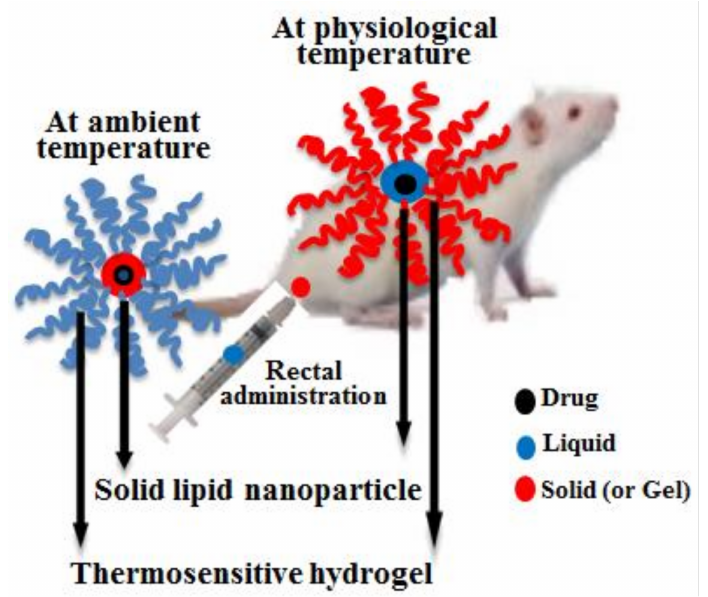
Figure 1. Schematic representation of drug-loaded double-reverse thermosensitive